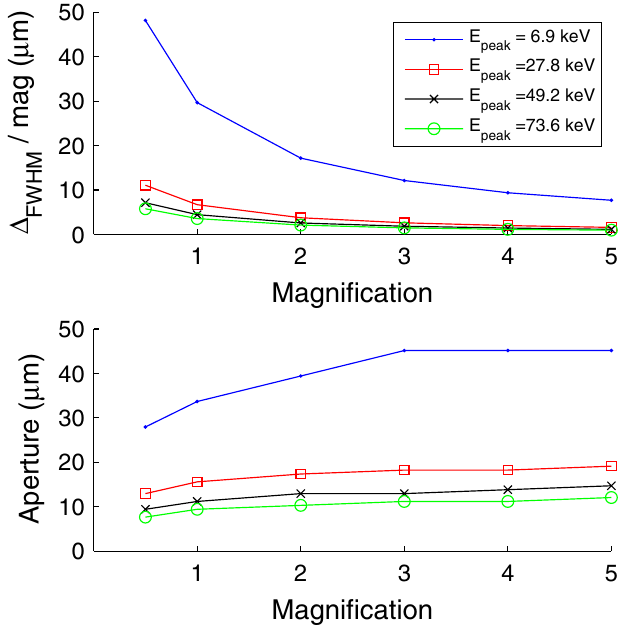
FIG. 11. (Color) Apparent point source size at the optimum aperture as a function of the magnification for the four cases shown in Fig. 10.